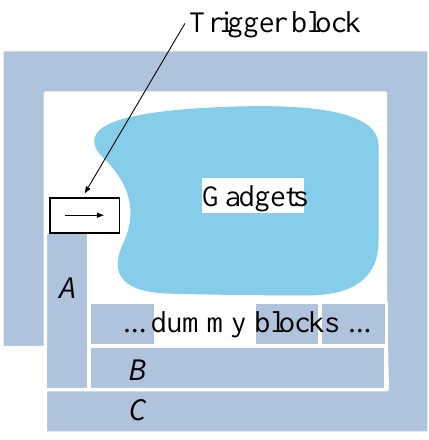
Figure 11. Frame that requires only one nonrectangular